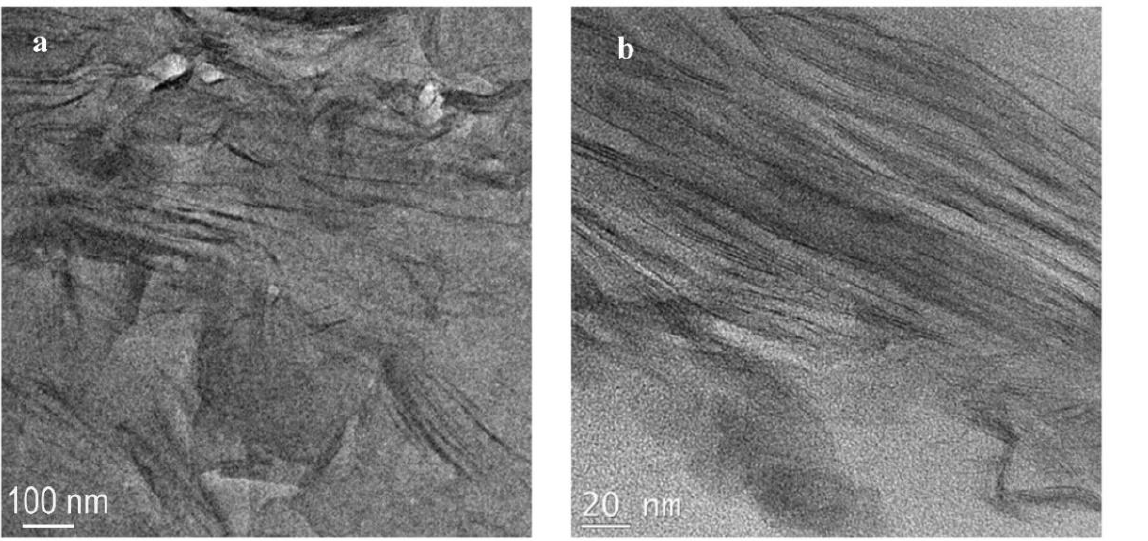
Figure 8. TEM micrographs for N6-Na + prepared by solution compounding at low ( a ) and high ( b ) magnifications.